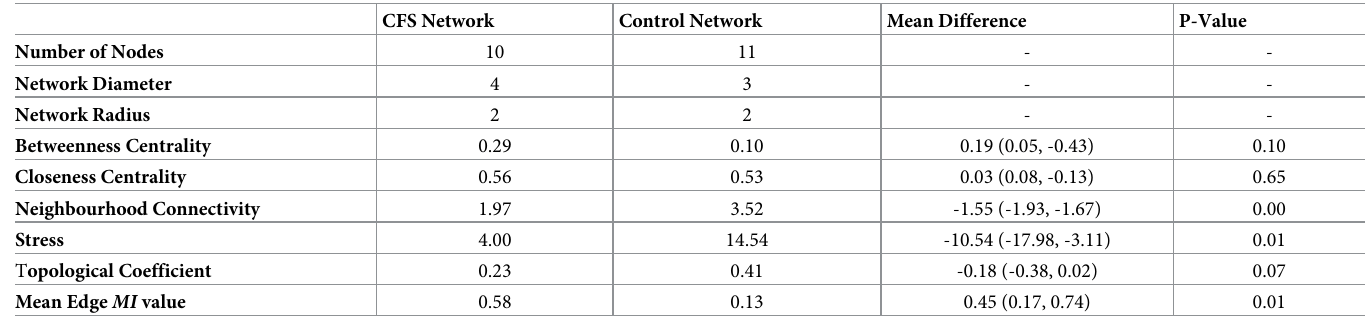
Table 2. Differences between CFS and control